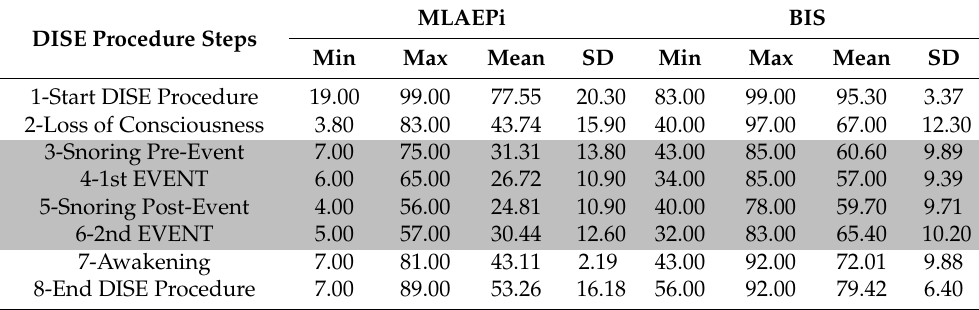
Table 4. MLAEPi and BIS descriptive statistics.